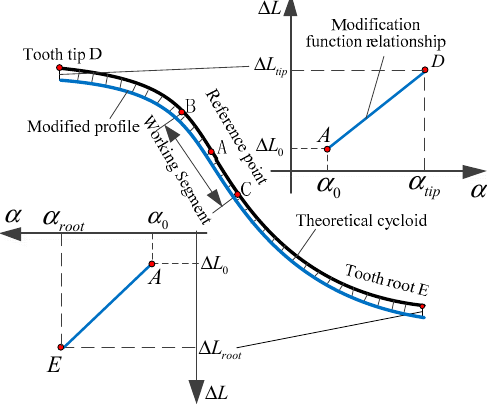
Figure 4. Tooth profile modification strategy of a cycloidal gear.